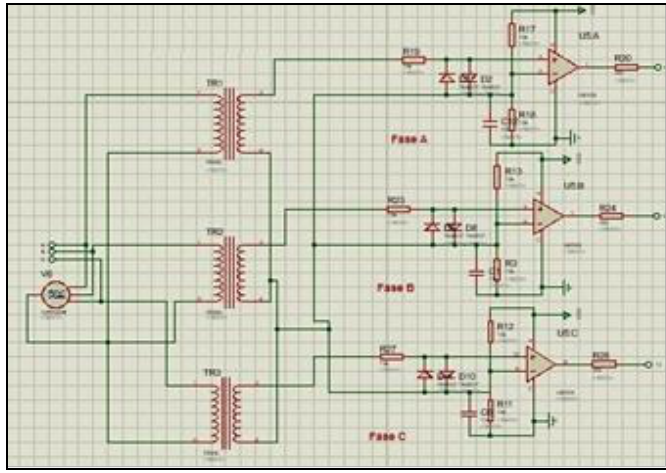
Figura 7: Bloque del detector de cruce por 0, para la sincronización.